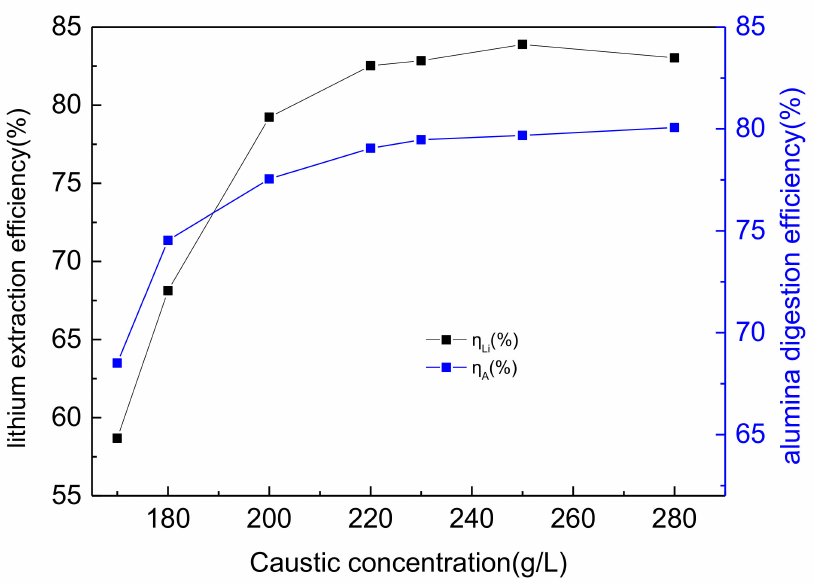
Figure 4. Effect of caustic concentration on lithium and alumina digestion behavior of bauxite (conditions: T = 265 ◦ C, mass ratio of CaO/ore = 8%, t = 1